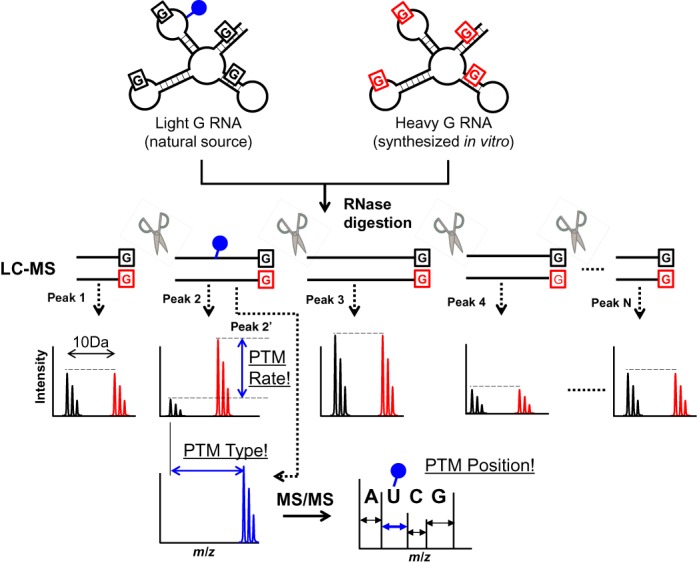
Schematic of SILNAS. RNA from natural sources or cells grown in 12C-containing guanosine (light-G RNA) is mixed with an equal amount of synthetic RNA that mimics the sample RNA but was transcribed in vitro with 13C10-labeled guanosine (shown by red Gs; heavy-G RNA). The mix is digested and analyzed by LC-MS. The sample RNA fragment without PTM elutes in a single peak with the corresponding heavy G-containing fragment as paired MS signals of an equivalent signal height at 10 Da apart, whereas a modified oligonucleotide elutes at a different chromatographic position from the corresponding heavy fragment and shows a distinct MS spectrum characteristic of each PTM. In SILNAS, the site of modification can be assigned comprehensively by searching the chromatographic peak containing only the light fragment, and the rate of PTM can be estimated quantitatively by comparing the signal heights of light and heavy fragments. The PTM site is determined by concurrent MS/MS analysis. Closed blue circle, a chemical group introduced by PTM.